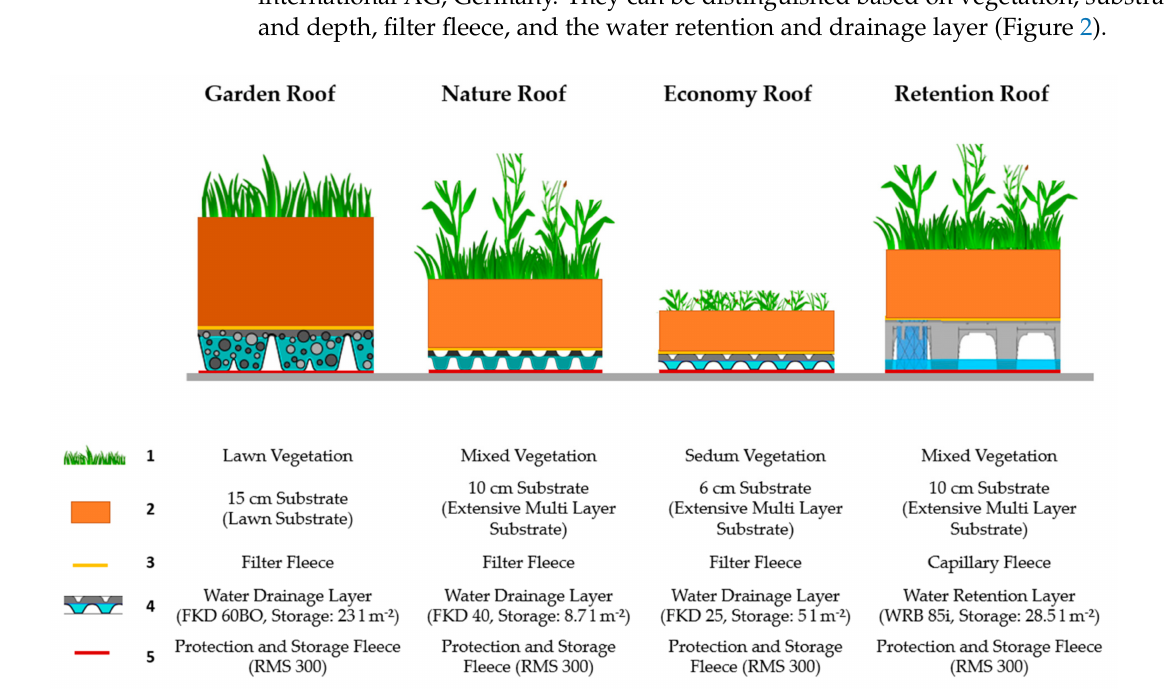
Figure 2. Description of the four different green roof systems used in this